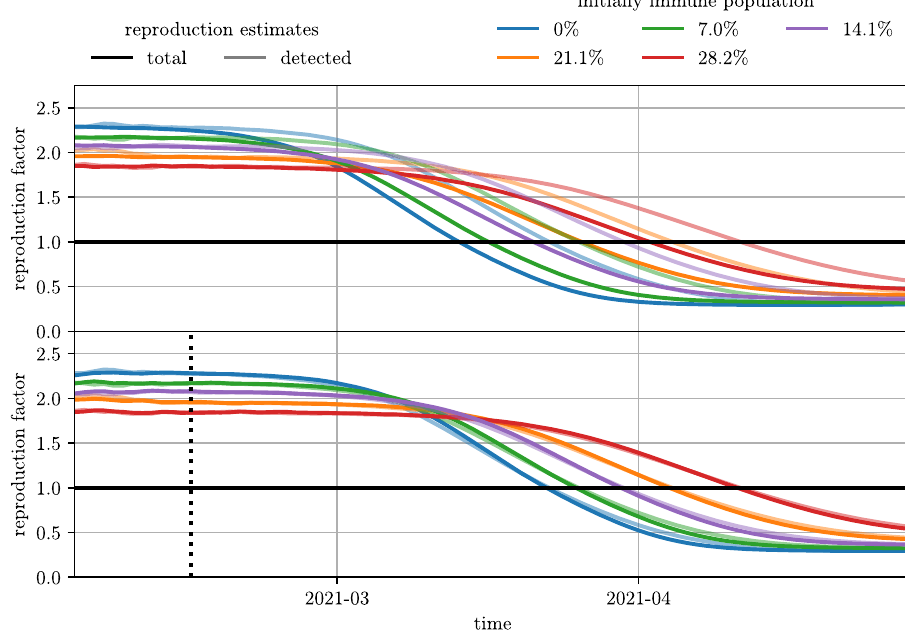
Figure 5. Estimates of the effective reproduction number for different initial immunization level. The effective reproduction number has been evaluated both on the total new cases as well as on the detected new cases. In the lower plot, the evaluation based on all new cases has been shifted to account for the time delay between infection and detection date. The black dotted line indicates the date (2021-02-14) used for evaluation of ˆ R det and eff .